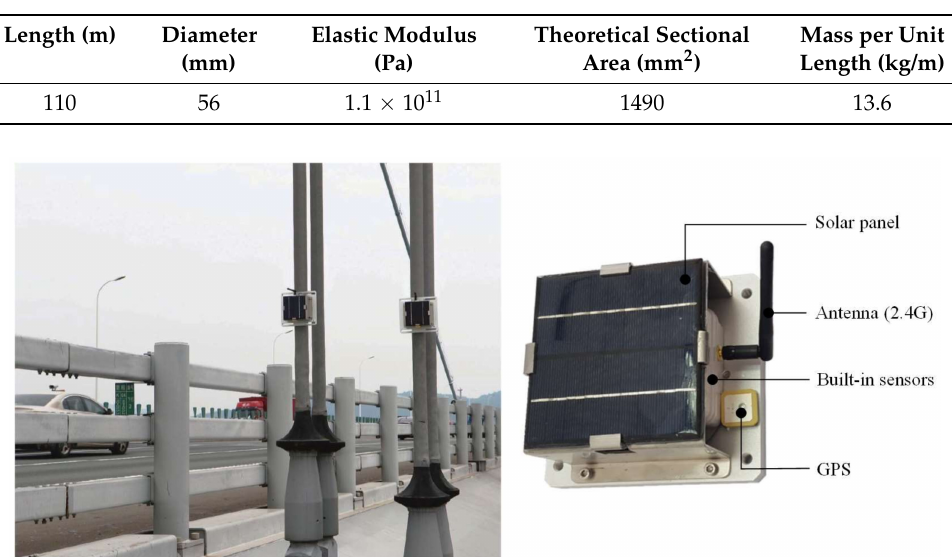
Table 3. Properties of the selected hanger cable.